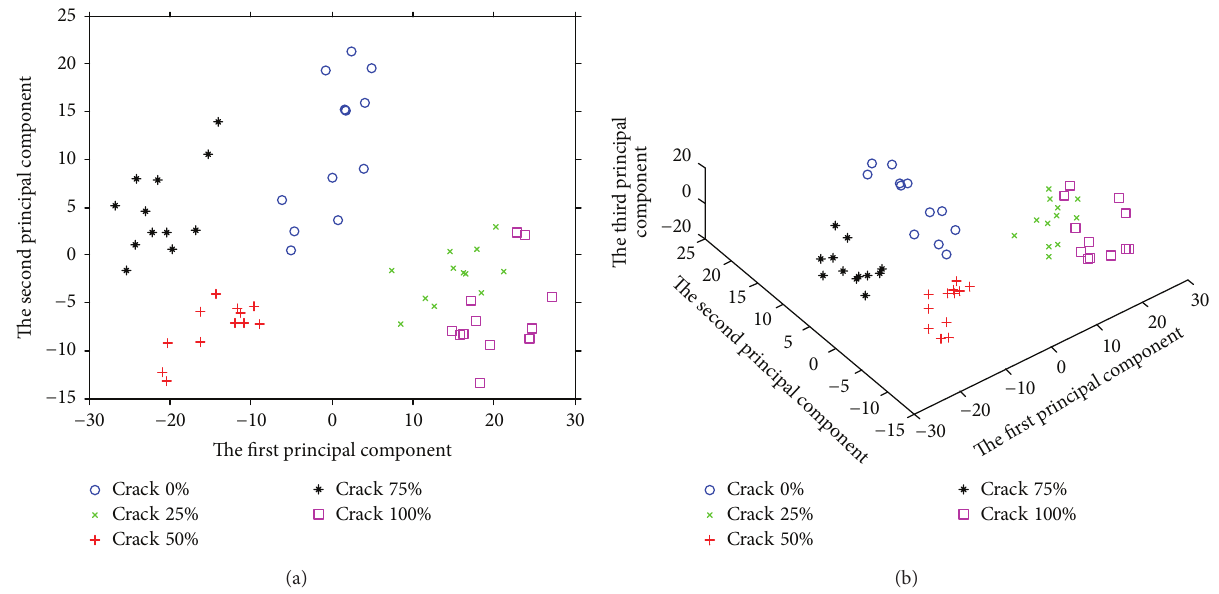
Figure 9: The principal components of the testing data for experiment 2 : (a) the first two principal components; (b) the first three principal